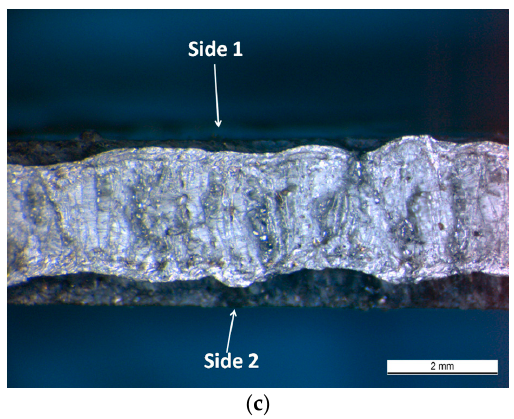
Figure 8. Optical microscopy image of welded joints in case of casted AlMg5 parts: ( a ) Ar, peak power = 3 kW, frequency = 10 Hz, pulse duration = 2 ms, 1 pass; ( b ) Ar, peak power = 5.5 kW, frequency = 10 Hz, pulse duration = 2 ms, 1 pass; ( c ) Side 1: Ar, peak power = 5.5 kW, frequency = 10 Hz, pulse duration = 2 ms, 1 pass; Side 2: Ar, peak power = 3 kW, frequency = 10 Hz, pulse duration = 2 ms, 1 pass.